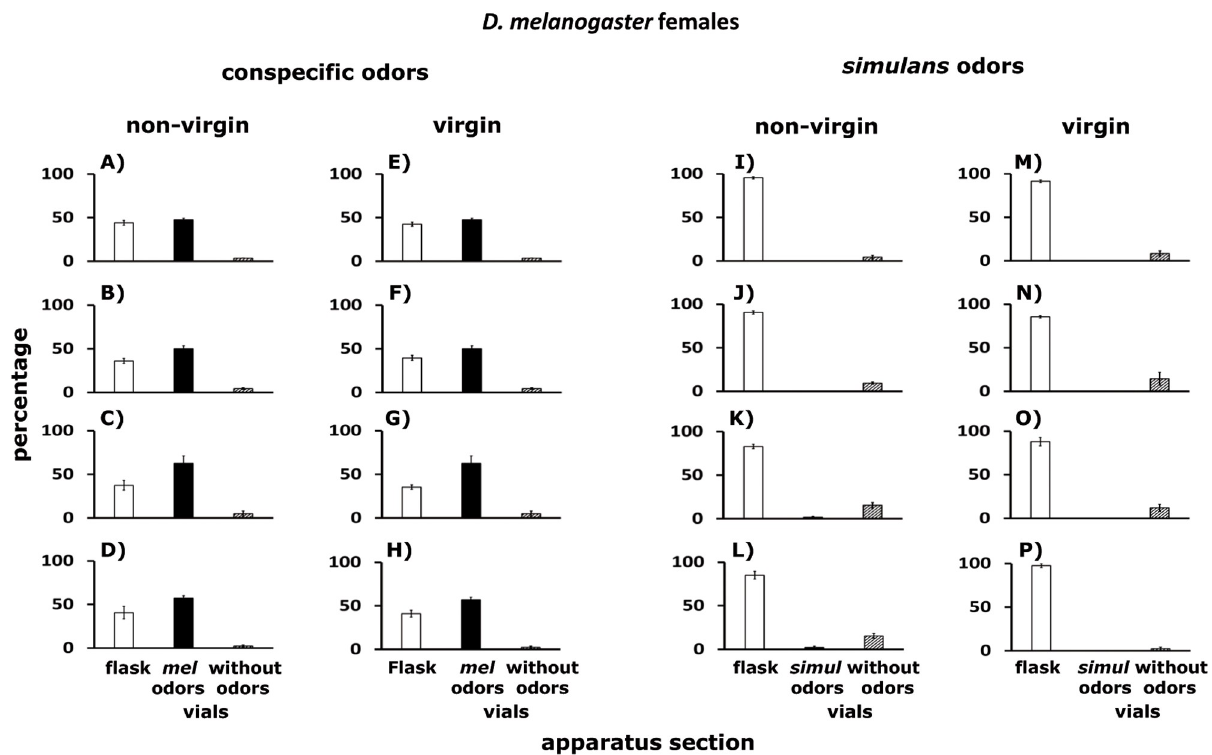
Fig 12. A—P. Dispersal patterns of D . melanogaster females confronted with odorants of conspecifics, and odorants of D . simulans . Females tested were non-virgin (A–D and I–L) and virgin (E–H and M–P). White columns indicate percentages of flies that remained in the flask. Black columns stand for percentages of flies found in the Y-tubes connected to vials with conspecific odorants. Hatched columns show percentages of flies in the Y- tubes connected to empty vials. For further details see Fig 11.